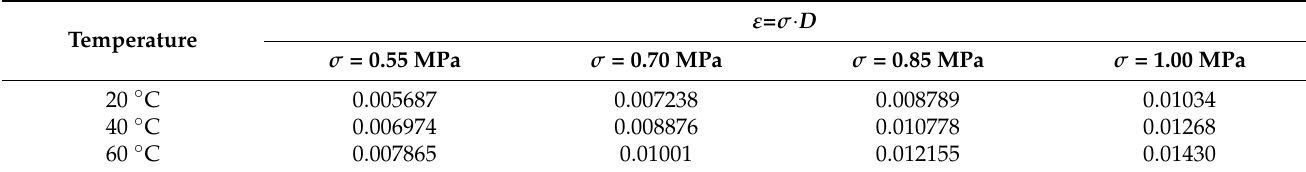
Table 9. Prediction of limit strain by the modified time hardening